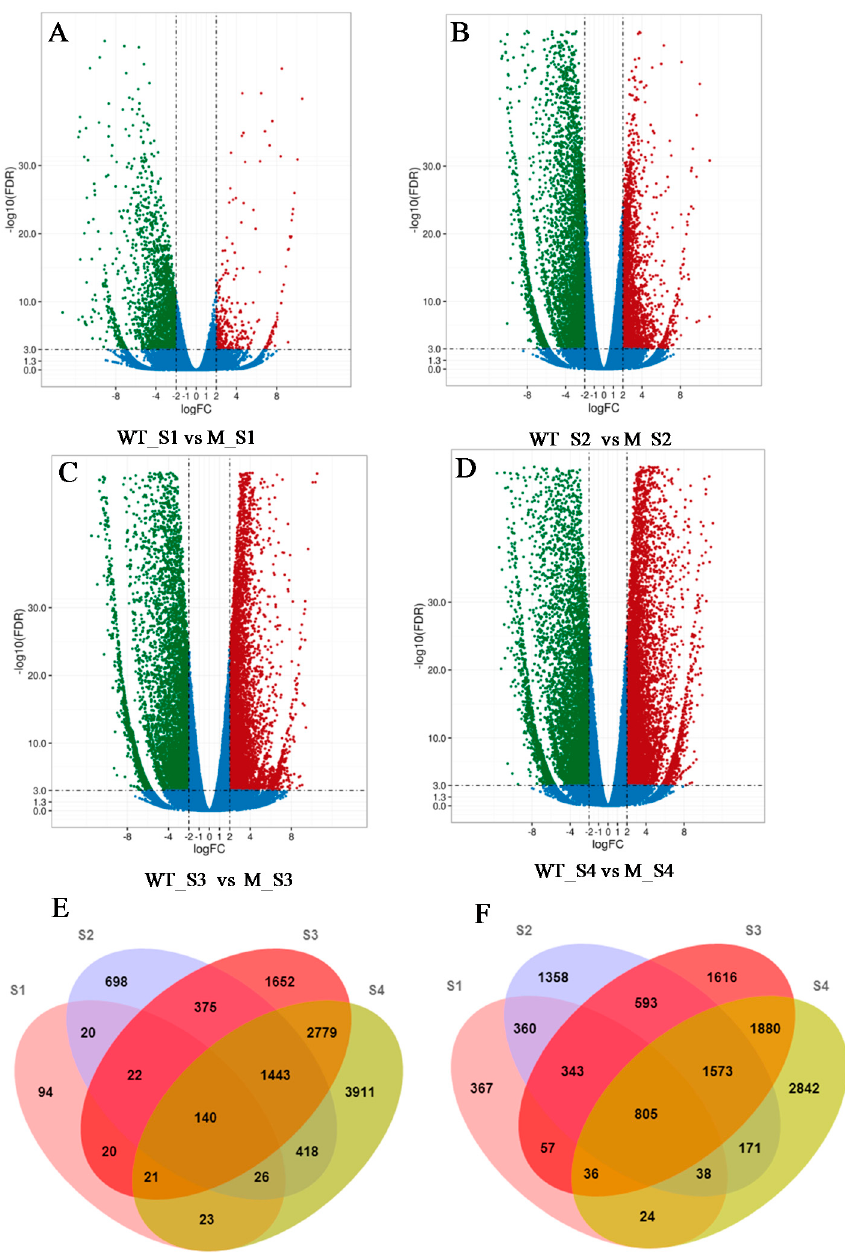
Figure 3. Volcano plots and Venn diagrams of DEGs. ( A – D ) DEGs between the WT and m68 at different stages shown by volcano plots. The X -axis represents the fold change difference in the expression of genes in different comparison groups, and the Y -axis indicates the adjusted p -values for the differences in expression. The green dots represent up-regulated genes in m68 , and the red dots represent down-regulated genes in m68 . Blue dots indicate genes without significant changes in expression; ( E ) Venn diagrams indicate the overlap in down-regulated genes between m68 and WT at different leaf senescence stages; ( F ) Venn diagrams indicate the overlap in up-regulated genes between m68 and WT at different leaf senescence stages. The numbers in each circle represents the down-regulated or up-regulated genes at different leaf senescence stage.